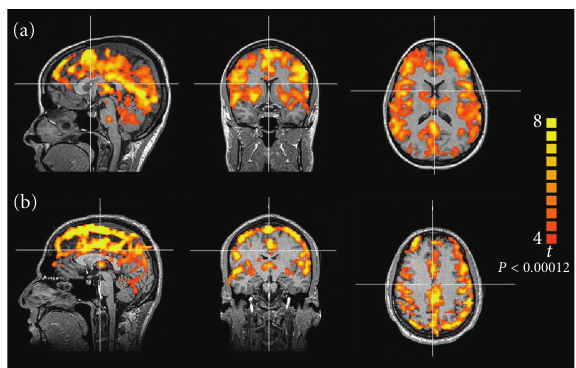
Figure 2: Representative BOLD signal maps showing global response to (a) breath-holding test and (b) CO 2 inhalation in healthy subjects.